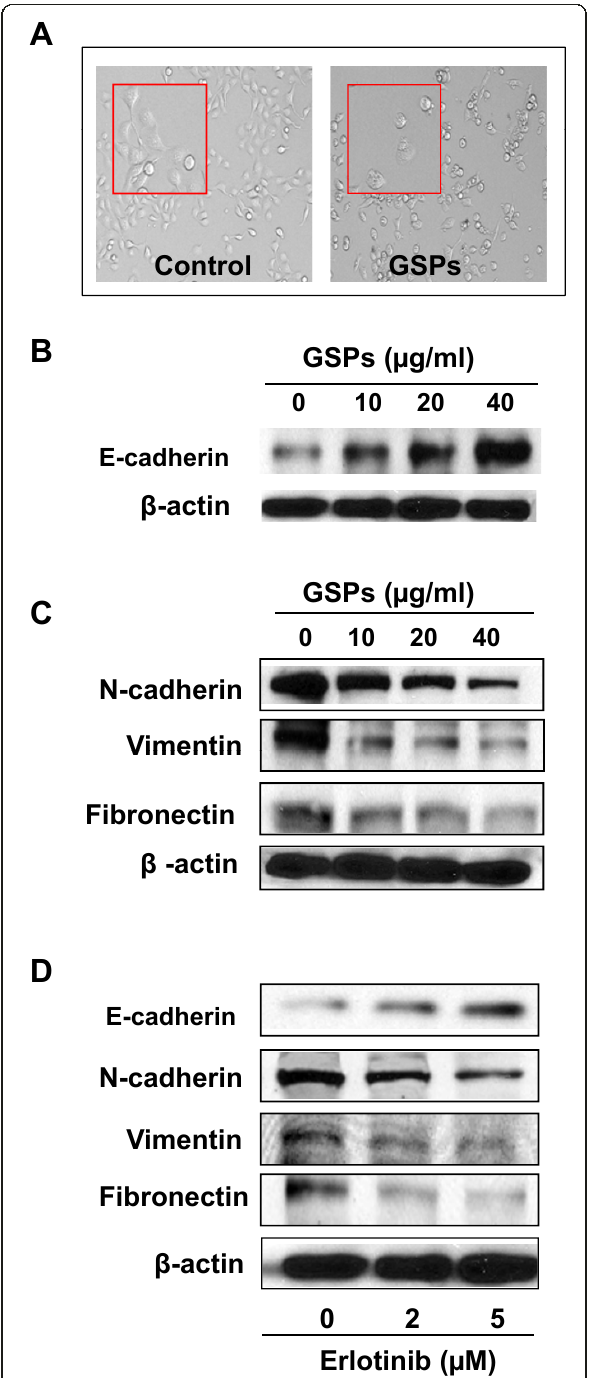
Figure 5 Treatment of SCC13 cells with GSPs reverses epithelial-to-mesenchymal transition . (A) Treatment of SCC13 cells with GSPs for 12 h resulted in loss of mesenchymal structure or morphology of cells. Cells lost their spindle shape morphology. Inset pictures showed magnified cell structure. (B) Treatment of cells with GSPs enhances the levels of E-cadherin, an epithelial biomarker, in the cells dose-dependently. (C) Treatment of cells with GSPs decreases the levels of mesenchymal biomarkers in